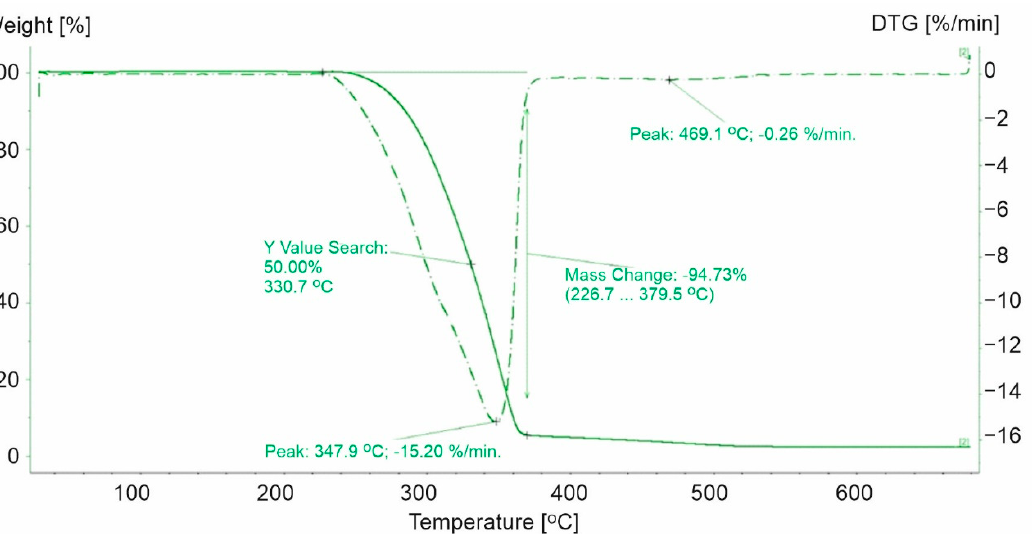
Figure 2. TG and DTG curves for PP ‐ 2. The green line presents TG curve, while the green dot line presents DTG curve.